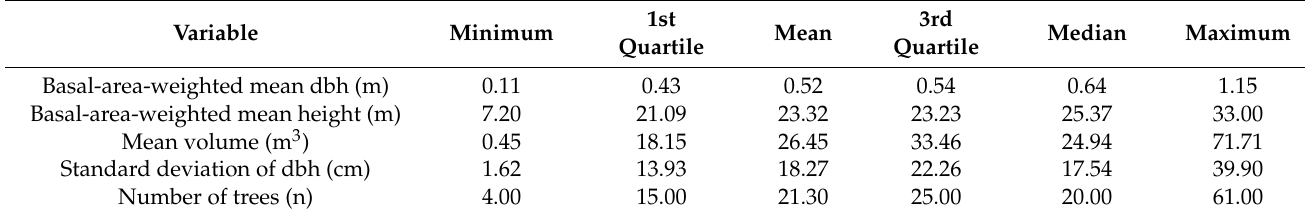
Table 1. Summary statistics of plot-level field data.